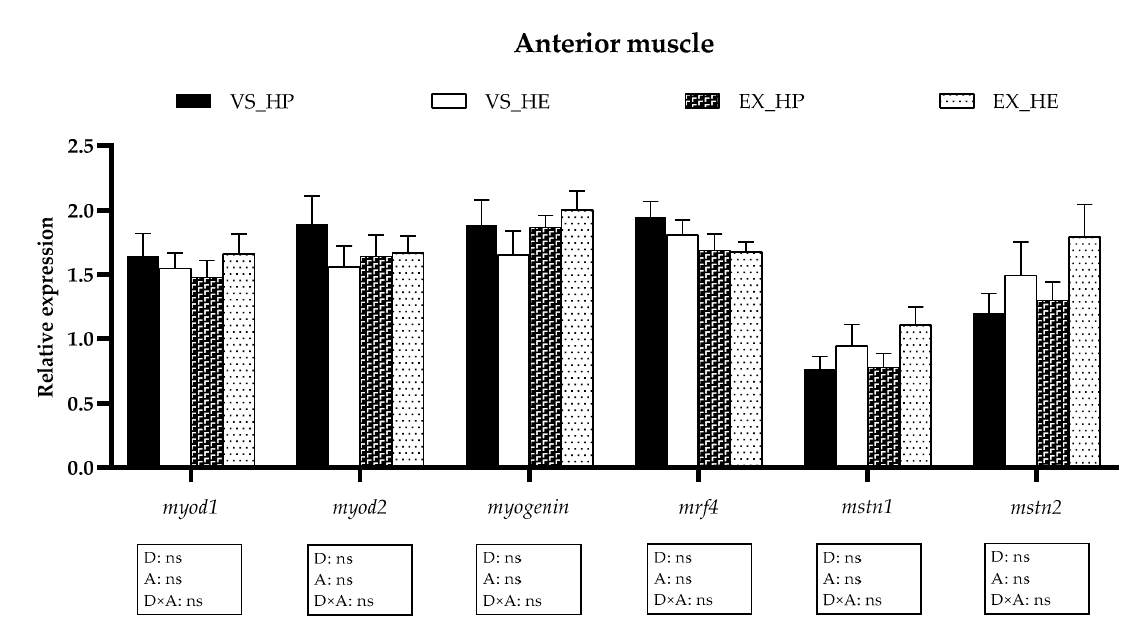
Figure 8. Relative gene expression of myogenic regulatory factors in anterior muscle of fish under voluntary swimming (VS) or sustained exercise (EX) and fed with the high-protein diet (HP) or high-energy diet (HE). Data are shown as means + SEM. VS, n = 12; EX, n = 16. Factorial statistical analysis was assessed by two-way ANOVA and p -values of factors diet (D), physical activity (A), and interaction (D×A) are displayed under graph.